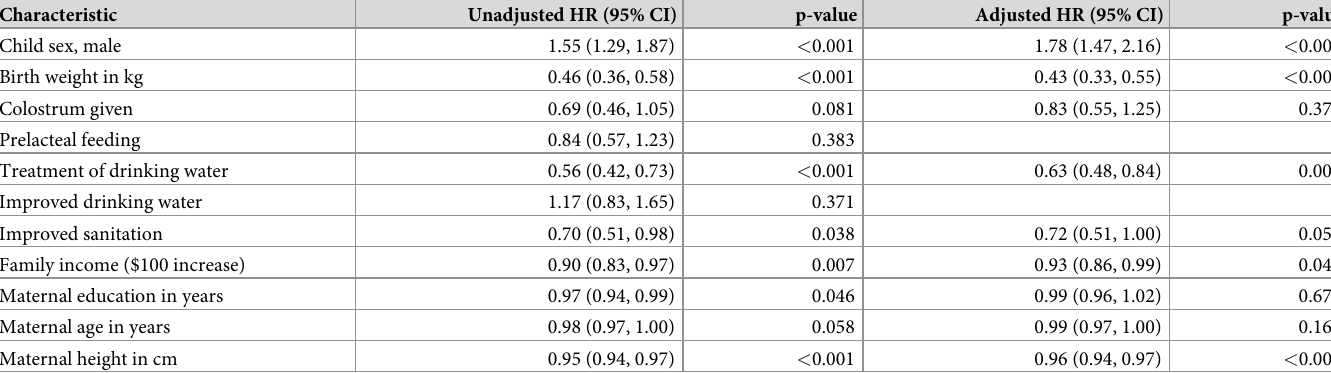
Table 3. Estimates of hazard ratios (HR) and 95% confidence intervals (CI) of first time stunting status using mixed-effects exponential proportional hazards regression model.